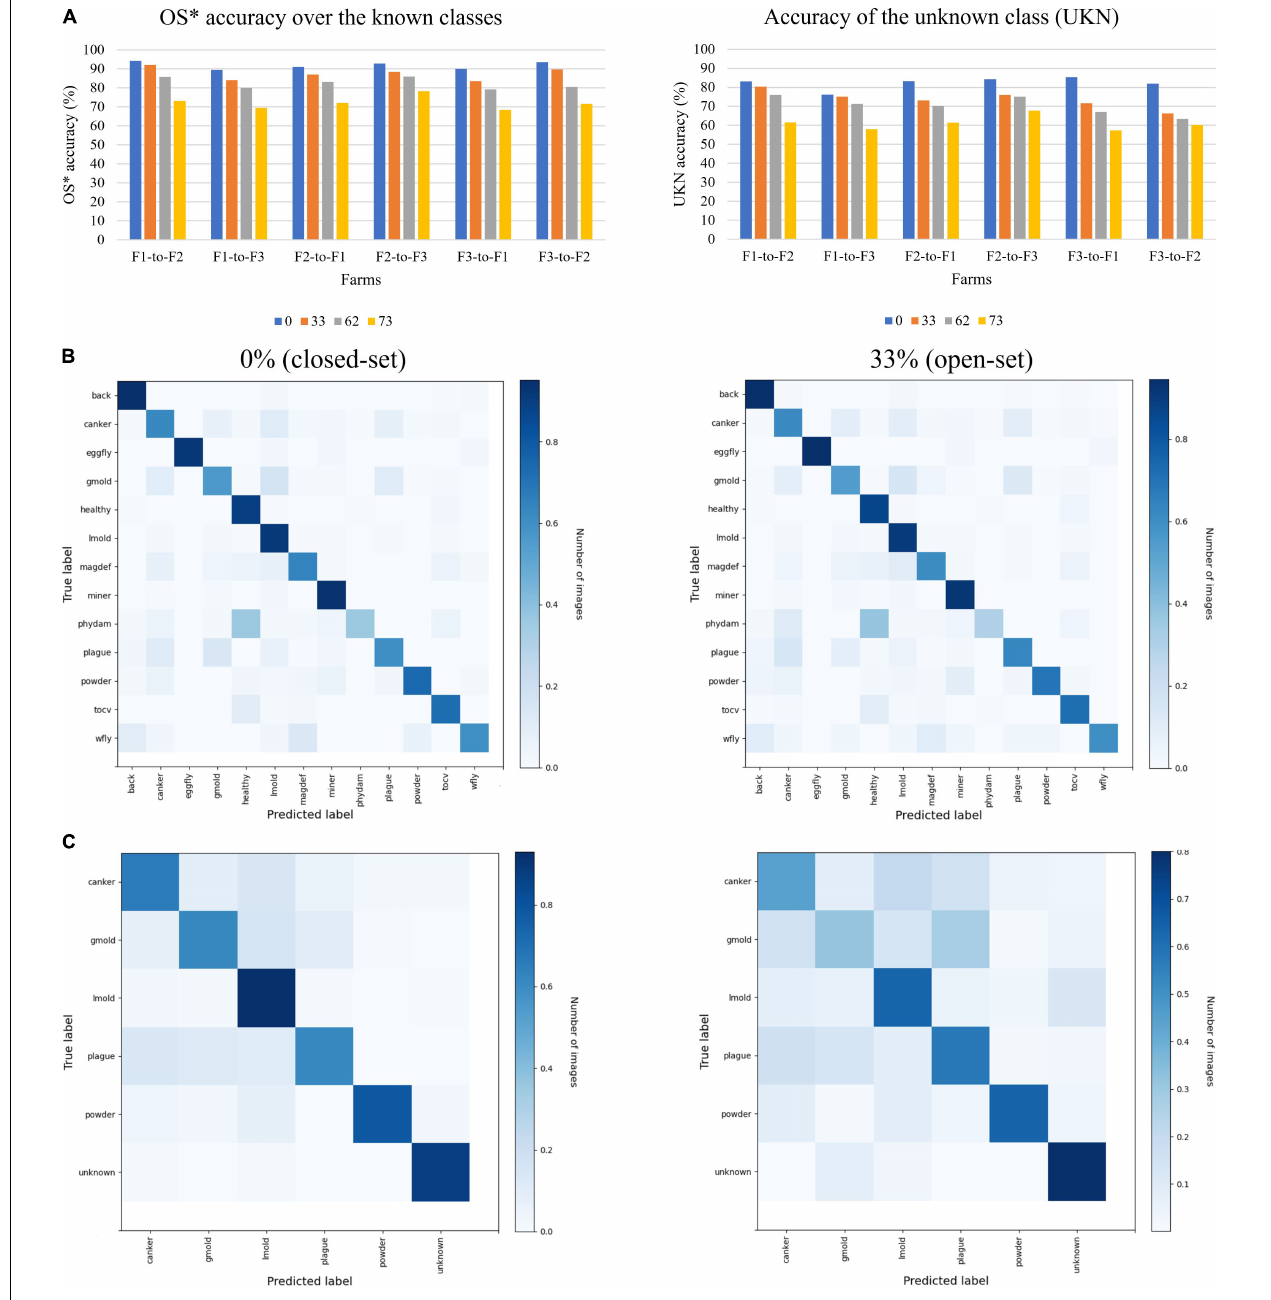
FIGURE 7 | Recognition of known classes vs. unknown class on the target dataset. (A) OS* accuracy over the known classes. (B) Accuracy of the unknown (UKN) class. Bars represent the openness levels from 0% (closed-set) to 33%, 62%, and 73%. (C) Confusion matrix of domain adaptation from Farm 1 to Farm 2 (F1-to-F2) with openness of 0% (closed-set) and 33% for the known classes. (D) Confusion matrices for some known classes and unknown class. The label abbreviations represent the following classes: back, background; gmold, gray mold; lmold, leaf mold; powder, powdery mildew; tocv, tomato chlorosis virus; wfly, whitefly; eggfly, whitefly egg; magdef, magnesium deficiency; phydam, physical damage.